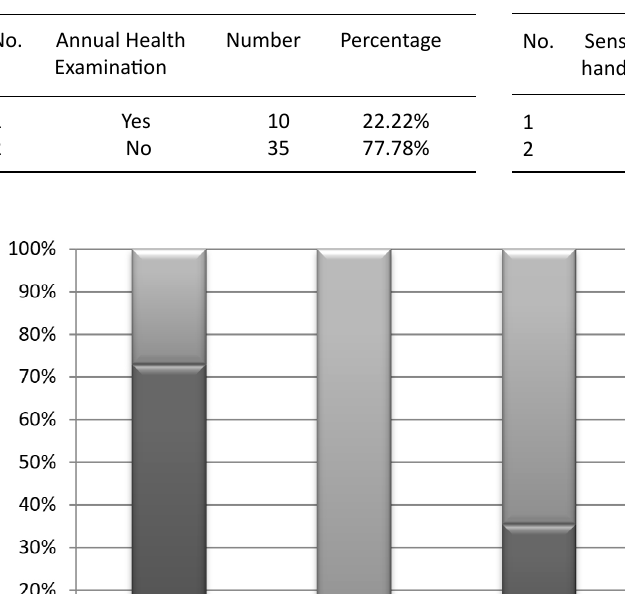
Table 5. Food handlers sensitized for hand hygiene